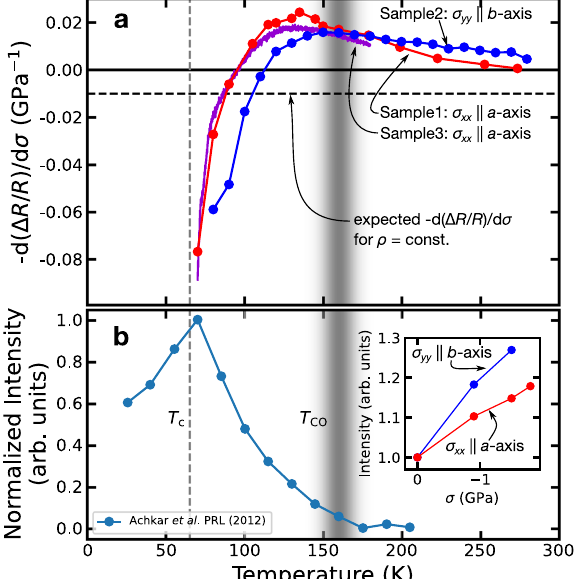
Fig. 3 Comparison of transport and diffraction signatures of charge order. a Stress response of the electrical resistance − d( Δ R / R )/d σ vs. temperature deduced from Fig. 2 (samples 1 and 2). Temperature sweep measurements at fi xed stress are shown for an additional sample (sample 3). Here, the magnitude of Δ R / R was scaled by − 1 GPa to convert the result to − d( Δ R / R )/d σ . The horizontal dashed line marks the geometric contribution to − d( Δ R / R )/d σ for ρ = constant (Supplementary Note 3). b Temperature dependence of the normalized intensity of the Bragg re fl ections characteristic of static charge-ordering measured by resonant X-ray scattering, reproduced from ref. 47 . The vertical dashed line and shaded area mark the superconducting transition temperature T c and the onset of static charge order T CO , respectively. Inset: Uniaxial stress dependence of the integrated peak intensity of both charge order domains with modulation propagating along the a - and b - directions, normalized to zero stress and summed together, extracted from the corresponding Bragg re fl ections 30 (Supplemen- tary Note